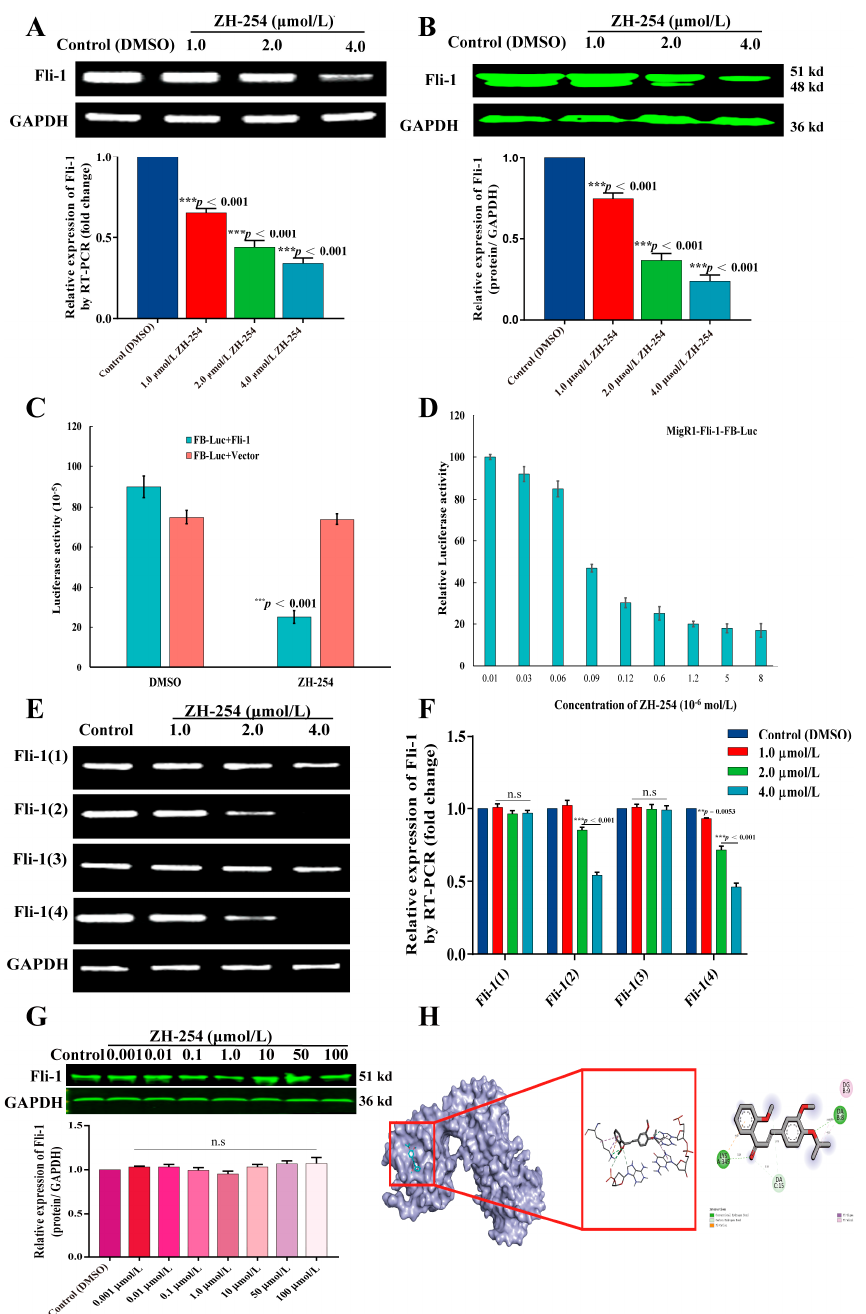
Figure 3. ZH-254 inhibits Fli-1 expression in HEL cells. ( A , B ) Expression and statistical results of Fli-1 at the mRNA and protein levels in HEL cells. ( C ) Import MigR1-Fli-1 or MigR1-Vector into HEK293T cells with or without ZH-254. After 12 h, the luciferase activity was detected by the dual-luciferase report detection system. ( D ) When MigR1-Fli-1 is co-transfected with FB-Luc, the concentration of ZH-254 affects the luciferase activity of the Fli-1 reporting plasmid driven. ( E ) Effect of ZH-254 on Fli-1 isoforms in HEL cells and statistical analysis of the mRNA expressions of Fli-1 isoforms. ( F ) The histograms show relative Fli-1 expression in HEL cells, calculated using Image J. Use GAPDH as a housekeeper gene. ( G ) CETSA to detect the binding of ZH-254 to the Fli-1 protein. ( H ) Three-dimensional binding mode of ZH-254 into Fli-1; two-dimensional binding mode of the co-crystallized ZH-254 shows different interactions with amino acids in Fli-1. ** p < 0.01, *** p <